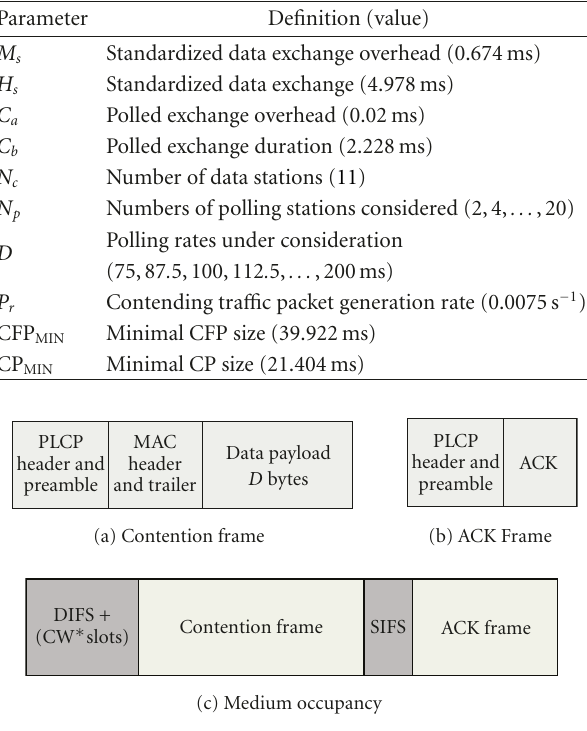
Figure 10: Contending frame